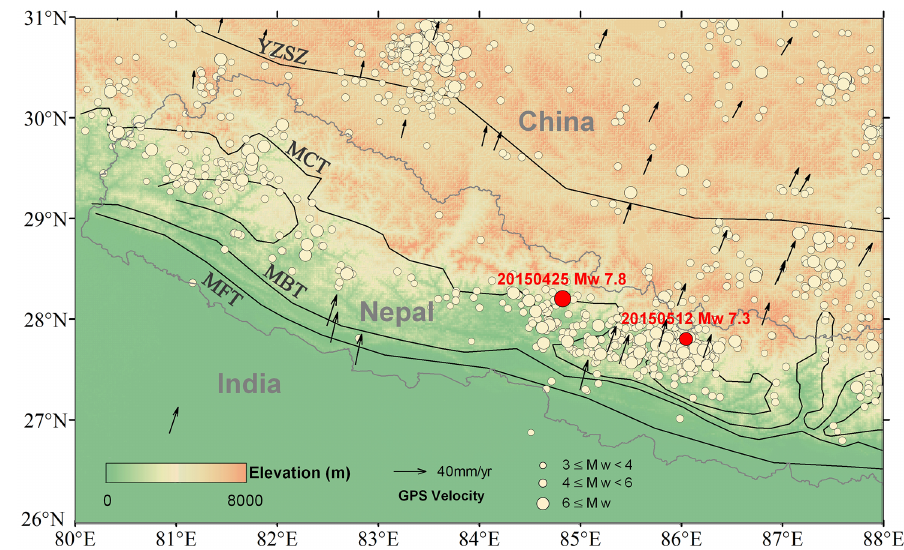
Figure 1. The distribution of earthquakes with magnitudes greater than 3.0 in and nearby Nepal from 1912 to 2022 (from USGS). GPS velocity field refers to Su et al. (2015). Black arrows indicate the average velocities and directions of ground movement in 1990–2015 from GNSS observations (Kreemer et al., 2014; Zheng et al., 2017).